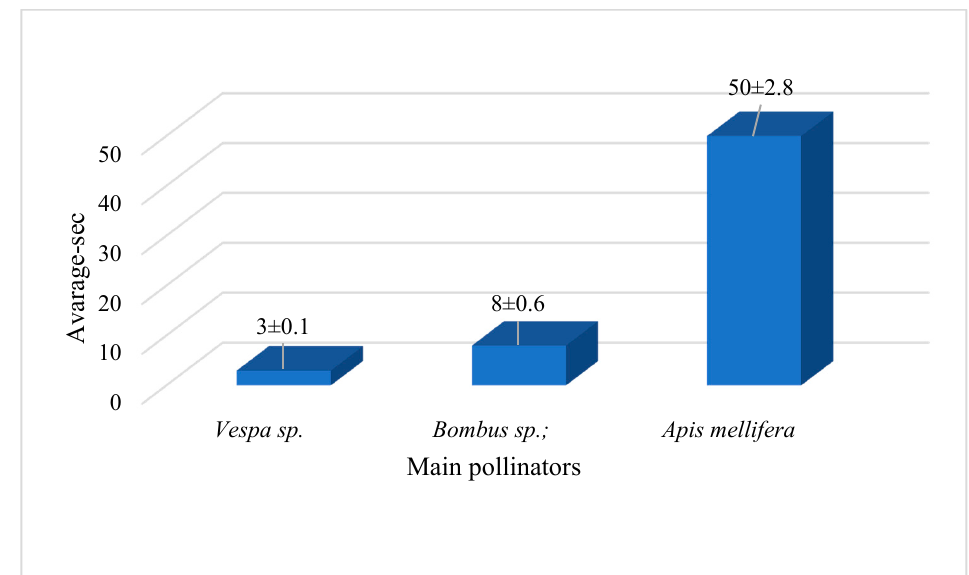
Figure 6. Duration of insect visits to flowers of F. aurea based on video recordings (X ± SE).